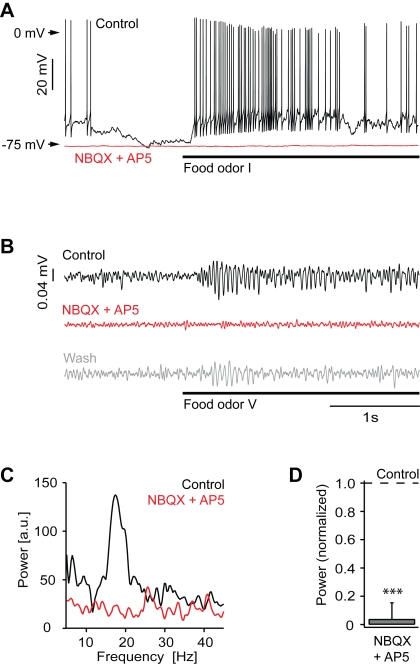
Ionotropic glutamate receptors are essential for odor responses of mitral cells.(A) Whole-cell recording from a mitral cell during odor stimulation (food extract; bar) before (black) and during (red) application of NBQX and AP5. (B) Local field potential recording during odor stimulation (food extract; bar) before (black) and during (red) application of NBQX and AP5 and after washout (gray). Traces are band-pass filtered between 8–43 Hz. (C) Power spectrum of local field potential traces (average of 6 trials; from unfiltered data) for the examples shown in (B). (D) Average local field potential power (15–30 Hz) in the presence of NBQX and AP5, normalized to control (n = 4 olfactory bulbs). ***, P<0.001.